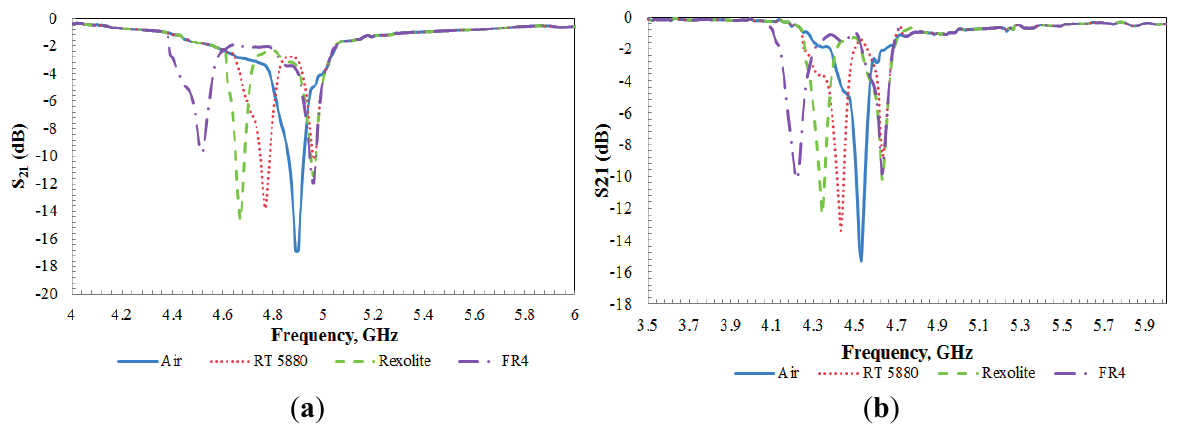
Figure 10. Measured magnitude of S ( b ) centered-gap